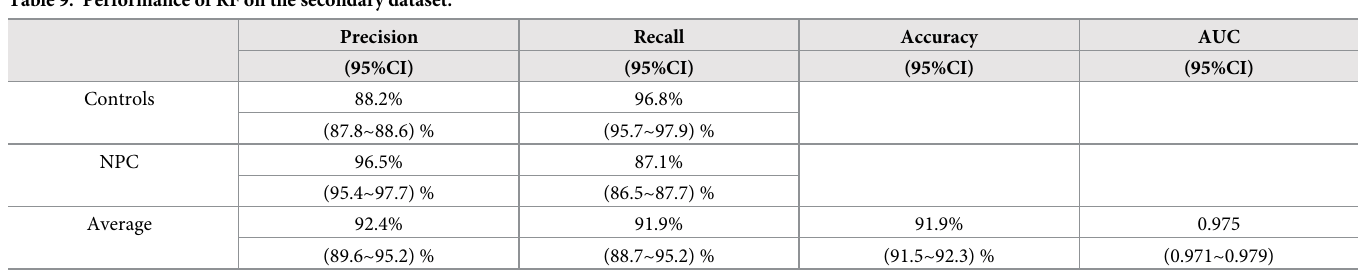
Table 9. Performance of RF on the secondary